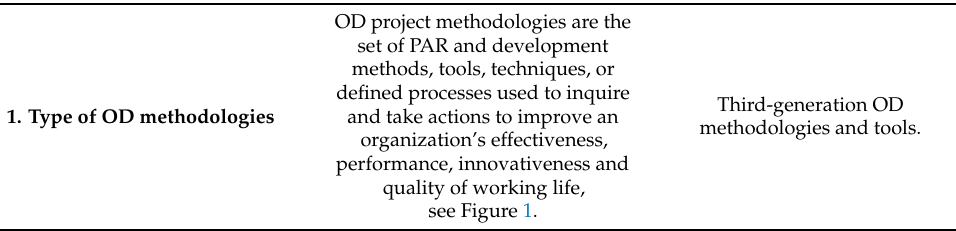
Table 1. Conventional concept-driven and research-assisted (PAR) dialogic organizational develop- ment (originally by Gilpin-Jackson 2013, modified for this